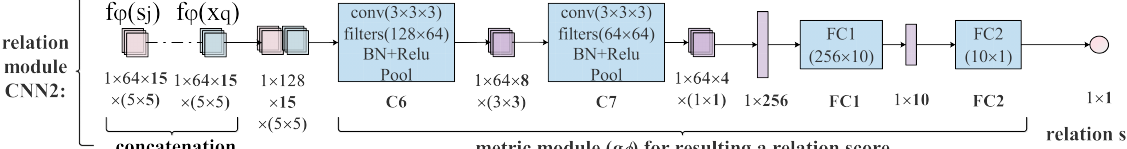
Figure 4. Architecture of the spatial-spectral embedding model, which is composed of five 3D-CNN blocks. The input data here consists of five support samples per class and a query sample from the DFC2018 dataset (where d × w × w = 233 × 13 × 13 )